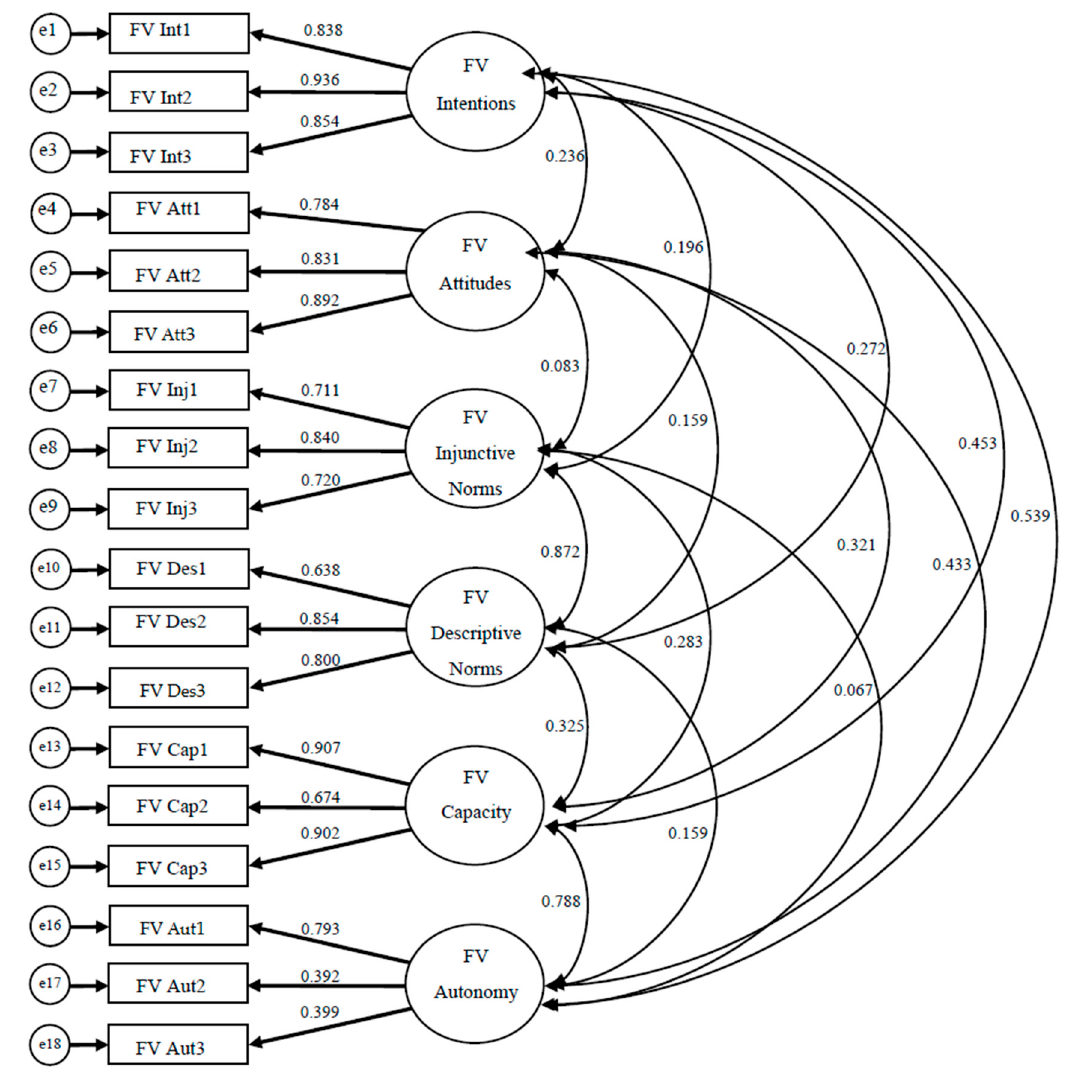
Figure 3. Results from CFA analyses for the fruit and vegetable monitoring instrument (FI = 0.972, TLI = 0.964, and RMSEA = 0.046).